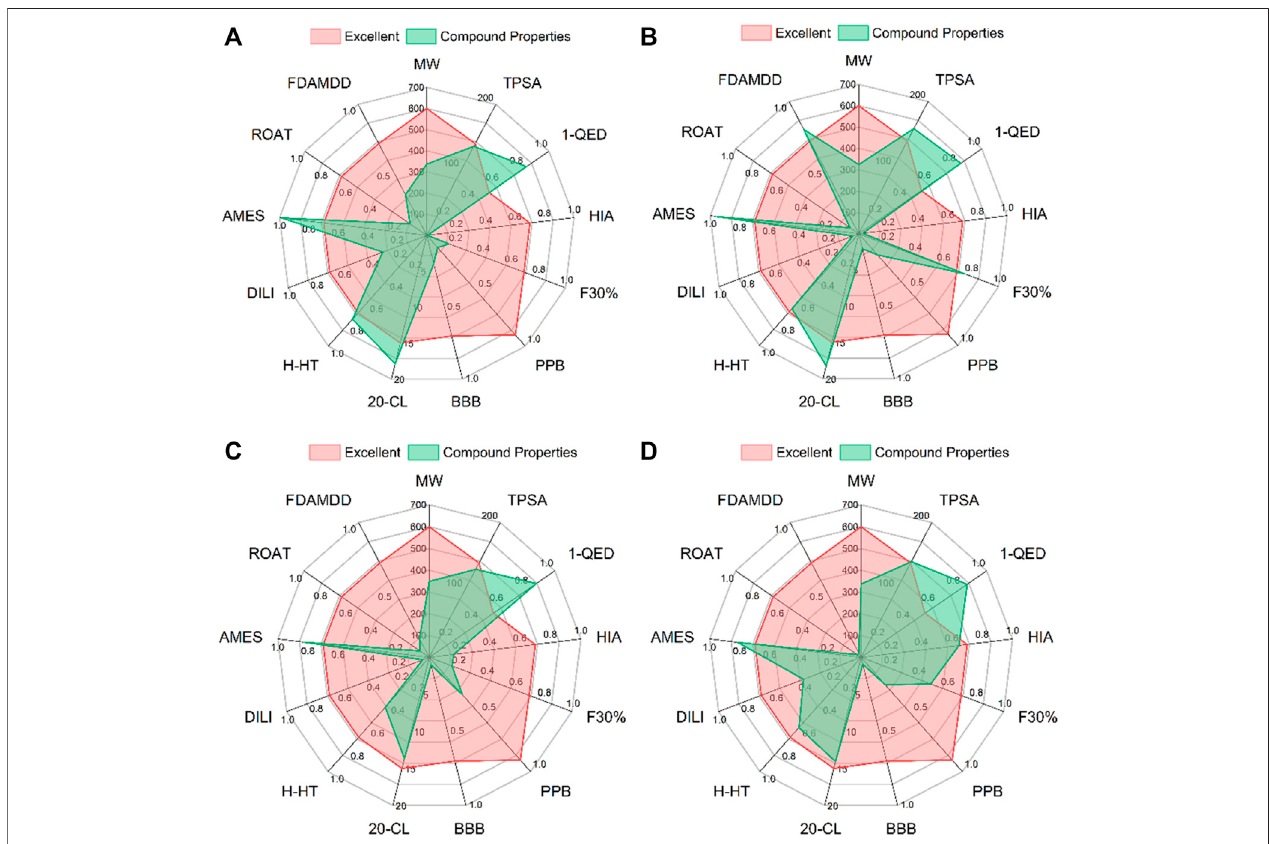
FIGURE 4 | The pharmacophysical and pharmaceutical properties of the four candidate compounds. From (A – D) are the docking patterns of L379, L528, L941 and L961, respectively.